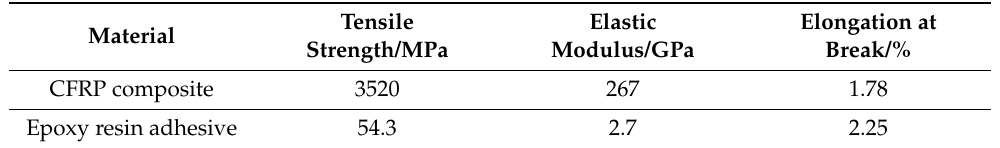
Table 1. Tensile properties of CFRP and epoxy